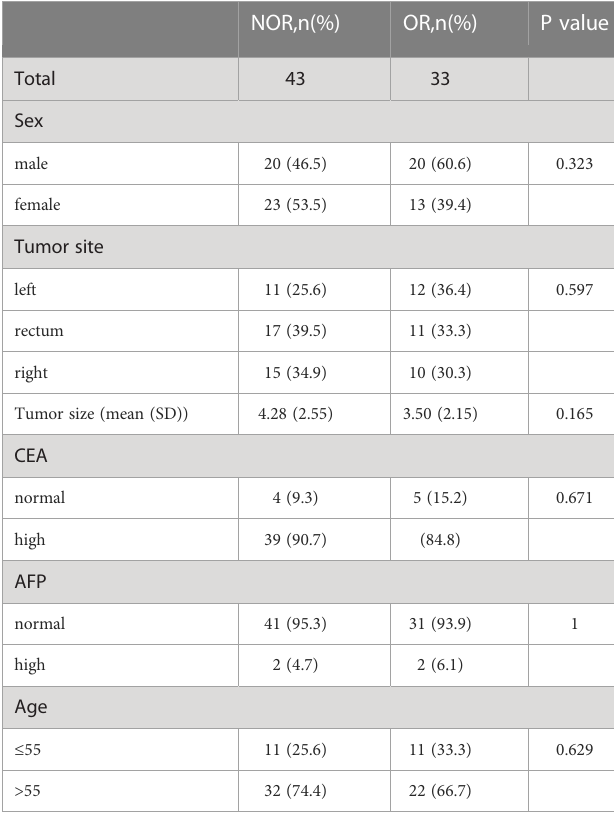
TABLE 2 Baseline clinical characteristics of the